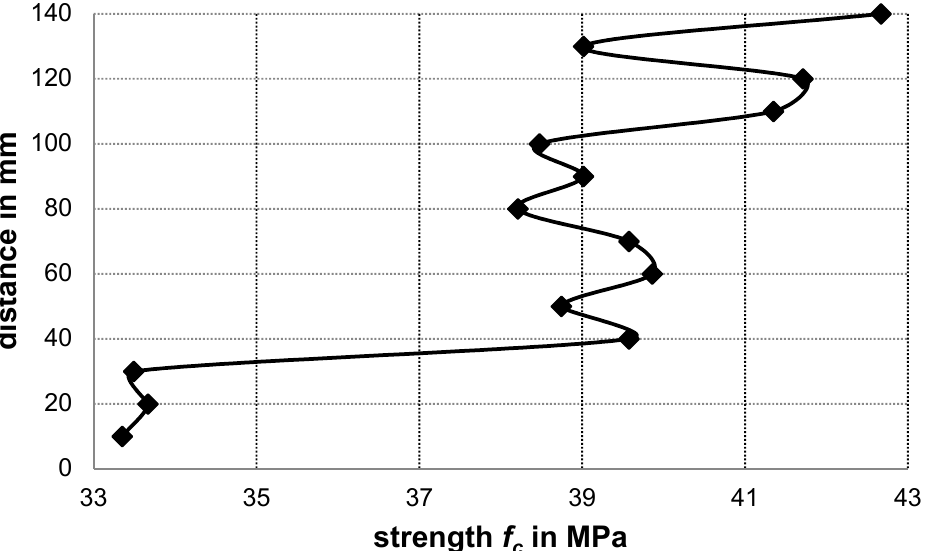
Figure 10. Compressive strength distribution in the sample taken from the slab heavily loaded with the fire (sample no. 008).